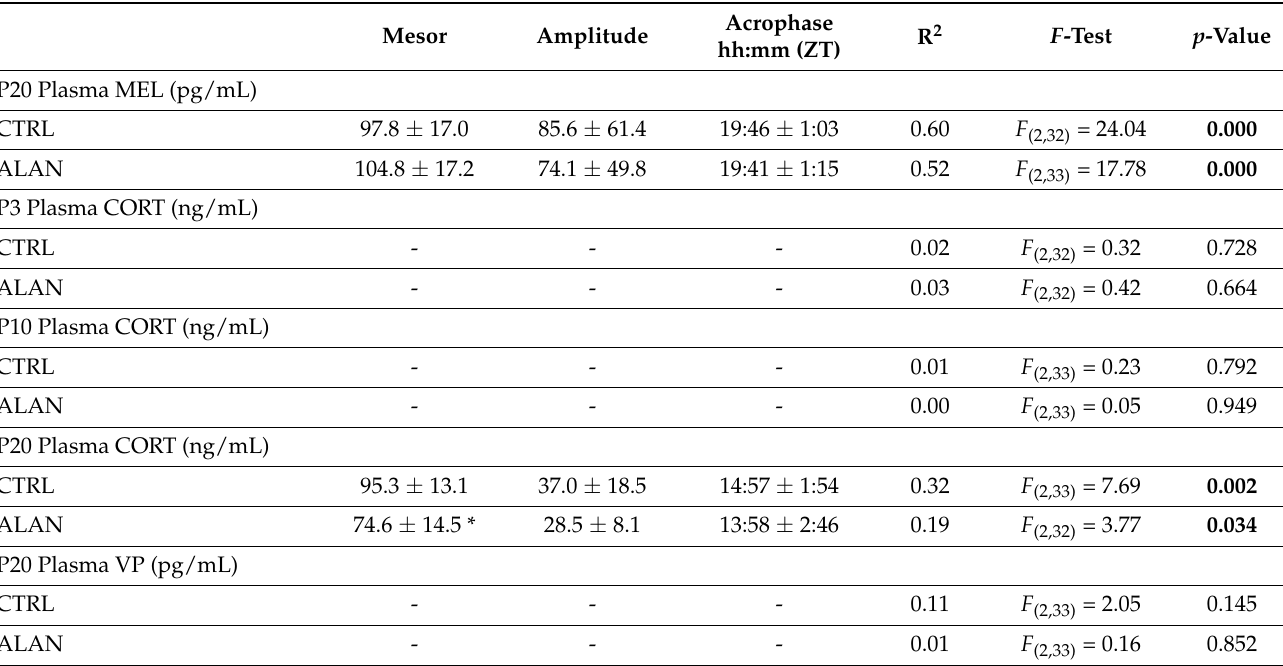
Table 1. Cont. Mesor